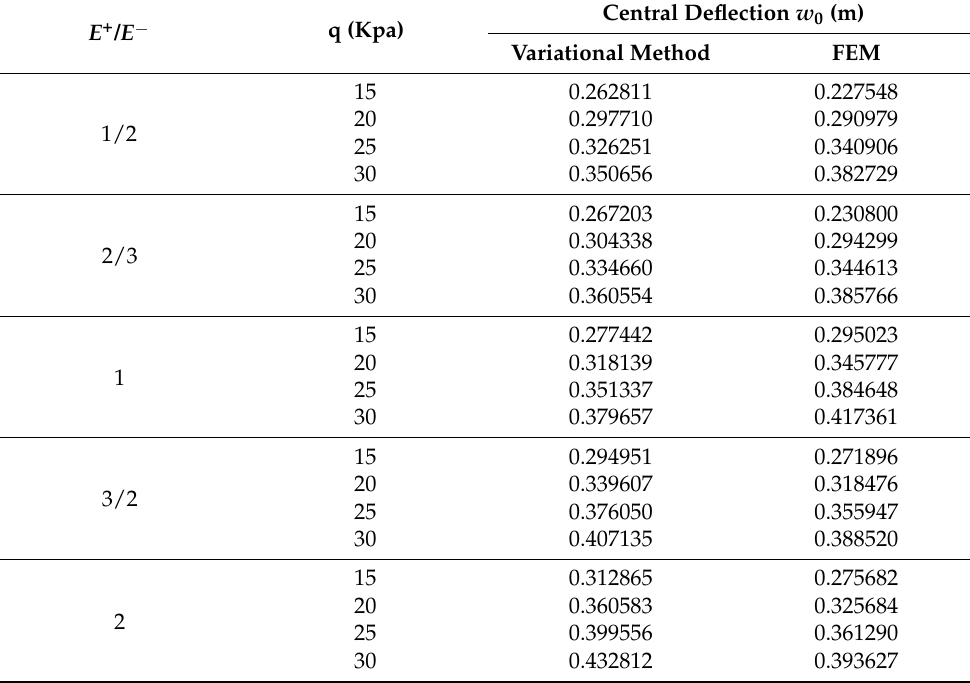
Table 1. Central deflections under different bimodular cases and loads ( Ra 2 / t = 1/2). E + / E − q (Kpa)